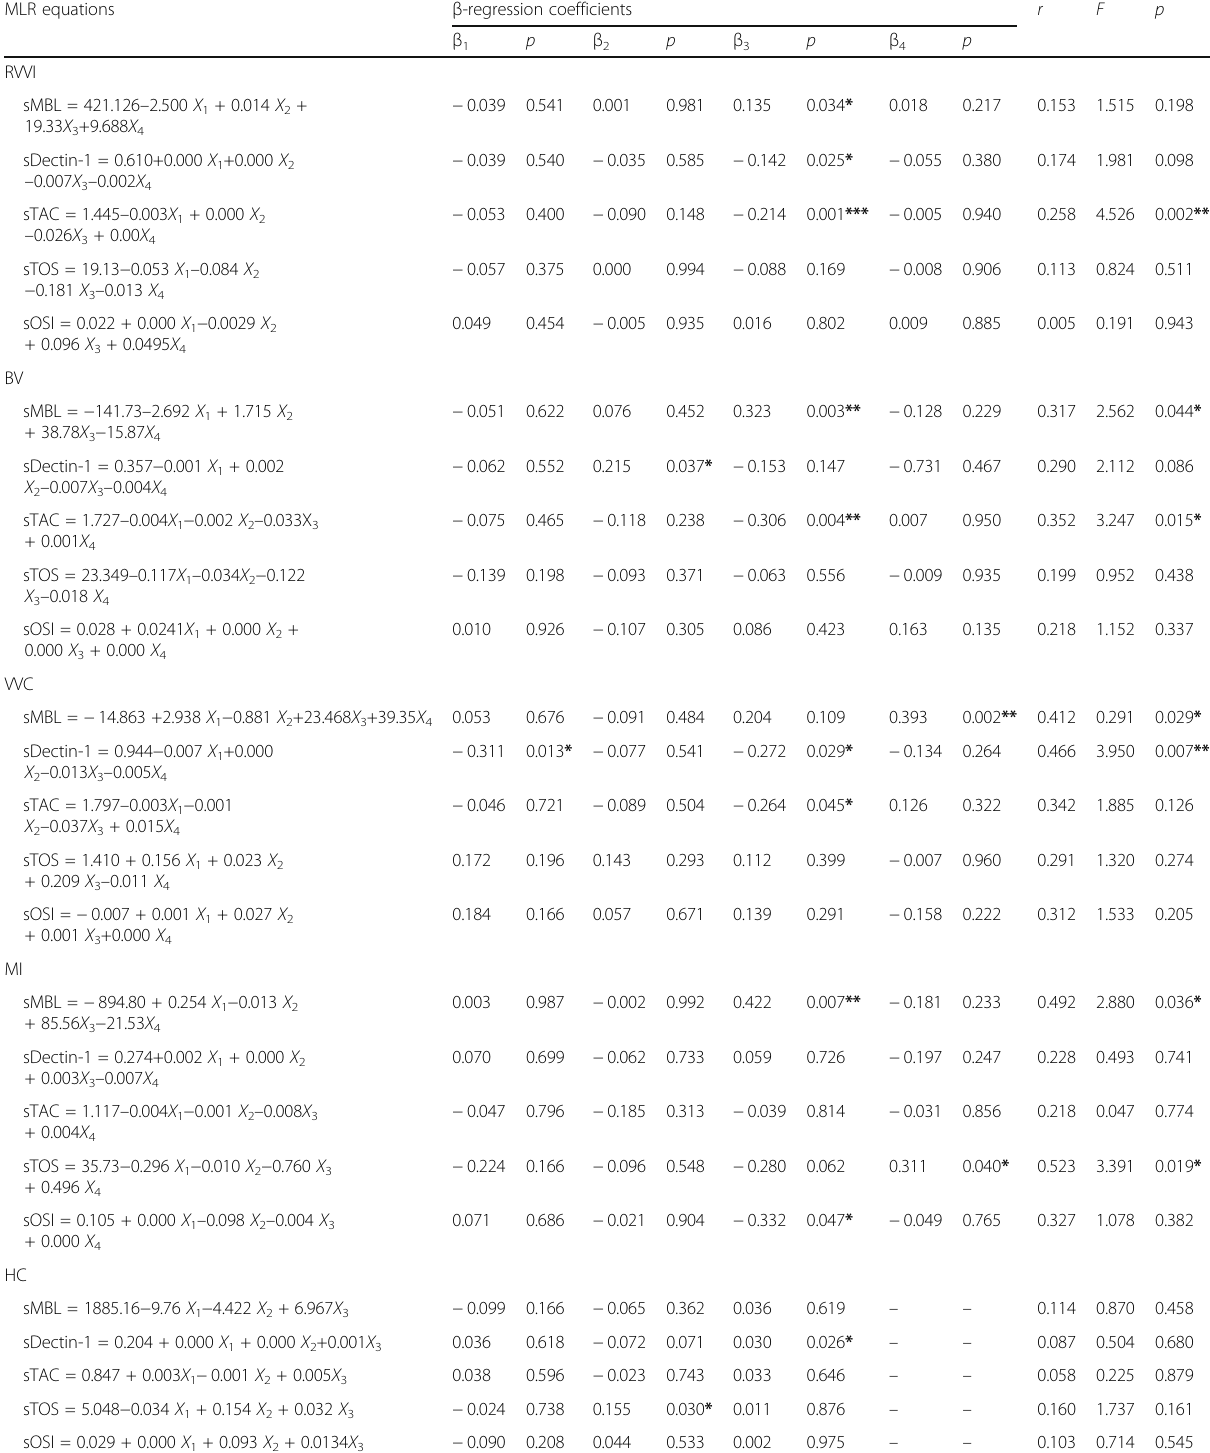
Table 5 Multiple linear regression analysis showing the effect of confounding parameters on serum biomarkers in RVVI, RVVI